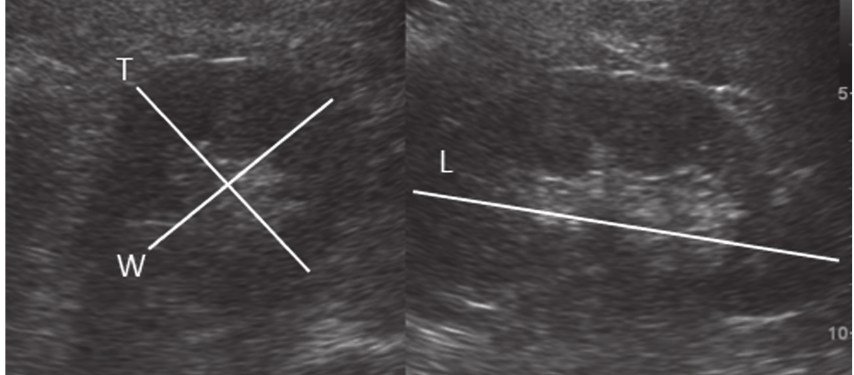
Figure 1 - Measurement of total kidney volume on the US image. T indicates thickness, W, width; L,